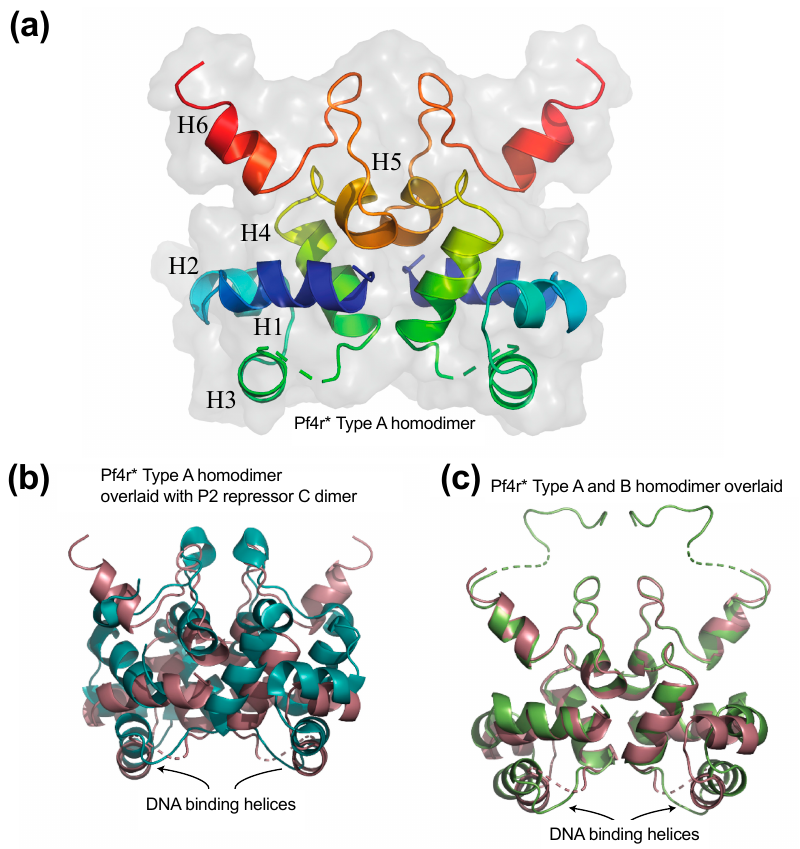
Figure 2. Crystal structure of Pf4r*. ( a ) The structure is coloured from the N-terminus (blue) to the C-terminus (red) in ribbon representation showing the symmetrical dimer formed by two chain As. The helices are numbered H1–H6, and the surface is rendered in transparent grey. ( b ) The Pf4r* Type A homodimer structure (brown) overlaid with the distantly related E. coli P2 repressor C (cyan) (PDB 2XCJ), showing high conservation in structure. ( c ) Overlay of the two types of Pf4r* symmetric homodimer (Type A in brown, Type B in green) observed in the solved crystal. Differences arise within the spacing of the predicted DNA-binding helices.